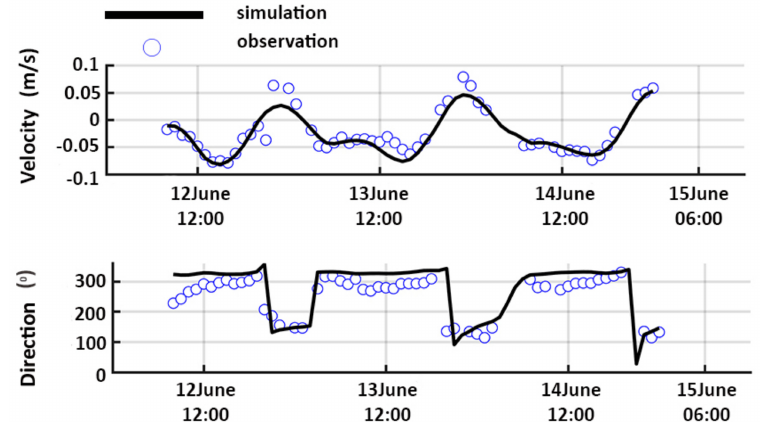
Figure 5. Comparisons of current speeds and directions between the modelled and observed data